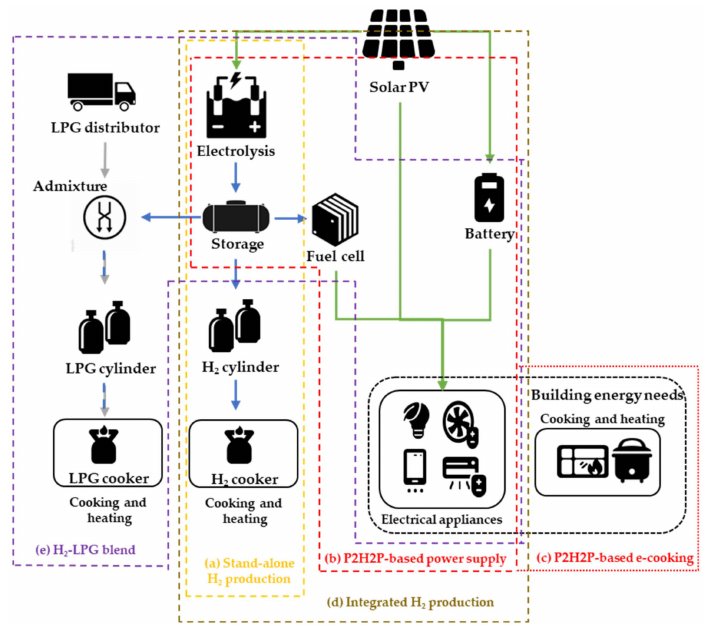
Figure 1. Different energy systems considered in this paper with integration routes of hydrogen to provide cooking services in off-grid communities: ( a ) stand-alone hydrogen production and utilization via combustion in hydrogen stoves; ( b ) stand-alone electricity supply system; ( c ) inte- grated hydrogen production system in the electricity supply system and utilization via combustion; ( d ) P2H2P-based e-cooking; ( e ) blending of hydrogen with LPG and combustion of the gas mix in an LPG